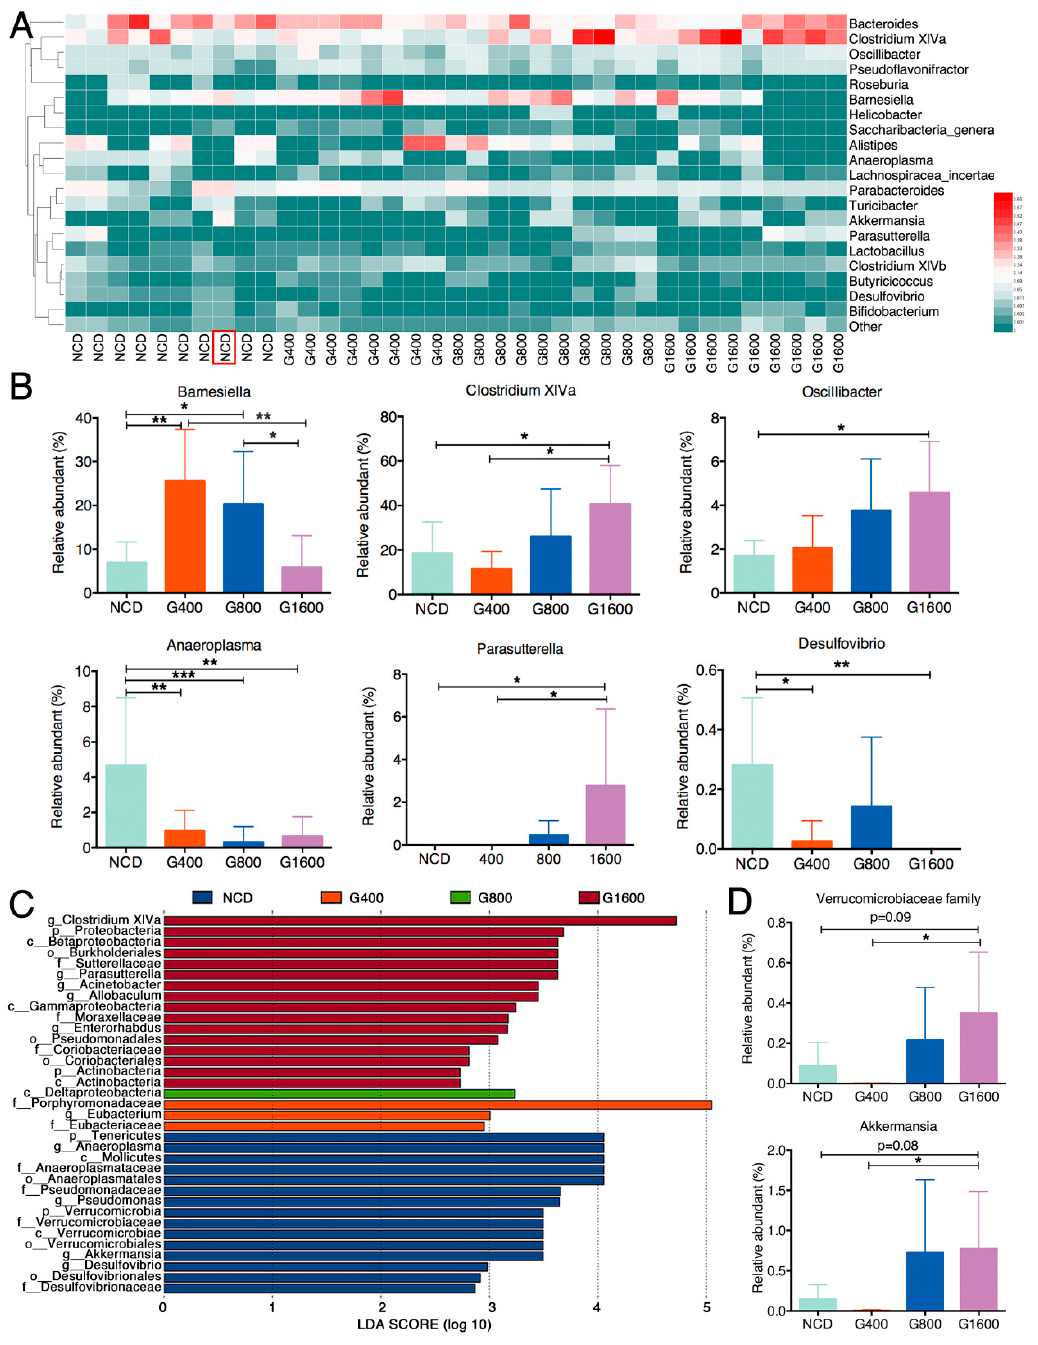
Figure 5. GML altered the fecal microbiota composition in mice. ( A ) The heat map of the relative abundance of the top 20 genera among di ff erent groups. The red color indicates high values while the green color means low values. ( B ) Relative abundance of the bacterial genera that di ff erentially detected in fecal samples among di ff erent groups. ( C ) a total of 35 taxa showed significant di ff erences in their relative abundance among the NCD, G400, G800 and G1600 groups with 2.5 as LDA score threshold. ( D ) The relative abundance of genus Akkermansia among four groups after eliminating the outlier which were detected with the ROUT method (Q = 1%) using GraphPad Prism Version 6. Results were expressed as mean ± SD ( n = 8–10), * p < 0.05; ** p < 0.01; *** p < 0.001.